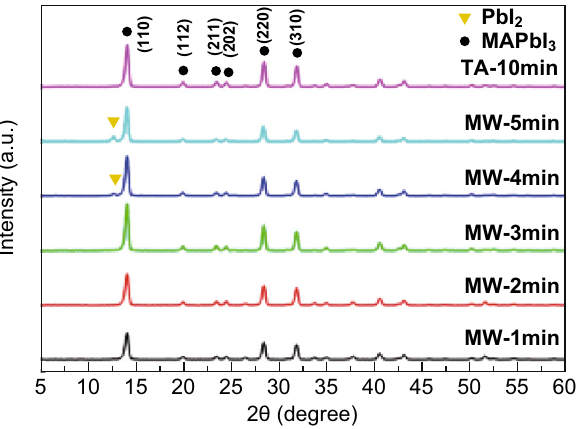
Fig. 9 XRD pattern of perovskite films treated by 160-W microwave irradiation for 1, 2, 3, 4, and 5 min and annealed at 100 (cid:3) C for 10 min. Reproduced with permission Ref. [27]. Copyright (cid:2) 2016 American Chemical